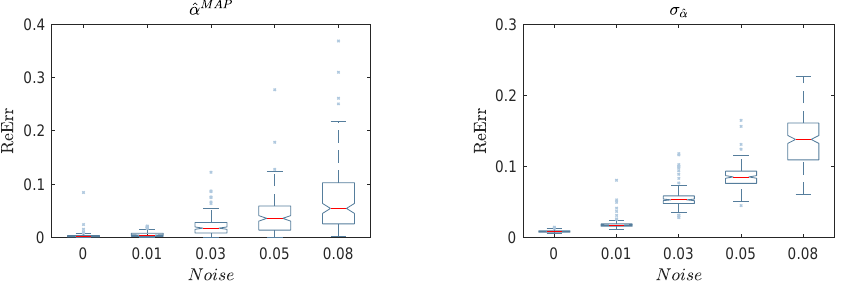
Figure 11. Reconstructed error (ReErr) of the identified damage severity ˆ α using the frequency-based algorithm: the MAP values ˆ α MAP ( left ); and the standard deviation σ ˆ α ( right ).